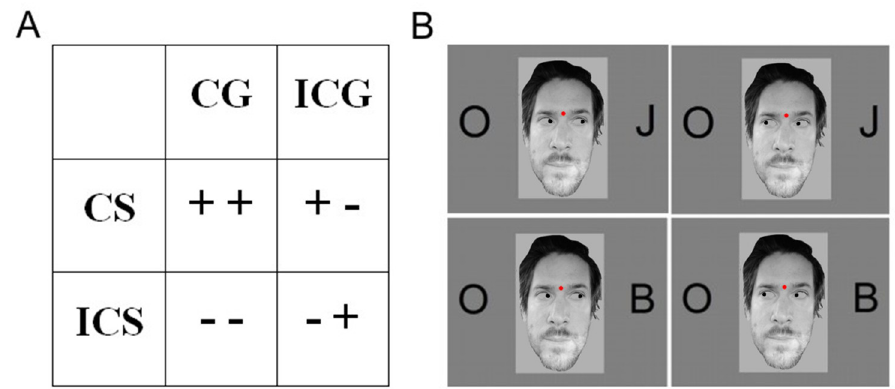
Fig 1. Different combinations of simon and putative gaze effects. (A) Different levels of correct response facilitation (+: facilitation,—: inhibition) for different combinations (trials) of Simon and Gaze conditions (CS: congruent Simon, ICS: incongruent Simon, CG: congruent Gaze, ICG: incongruent Gaze). (B) Stimuli of the four conditions (example): CS-CG on the top left, CS-ICG on the top right, ICS-CG on the bottom left, ICS-ICG on the bottom right.